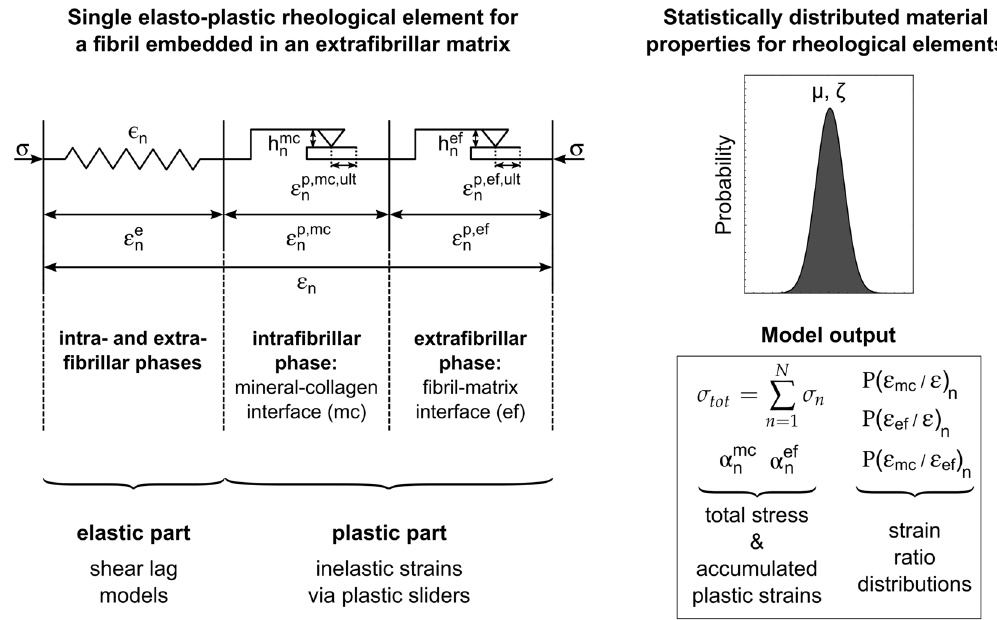
Figure 2. Elasto-plastic rheological model element to incorporate two inelastic strain mechanisms for the mineral-collagen (intrafibrillar) and fibril-matrix (extrafibrillar) interface coupled with a statistical material description. Left, a single rheological model element combines an elastic spring and two plastic sliders for these interfaces, which are set in series, and are loaded under a compressive stress σ . The series arrangement reflects the underlying shear lag and allows different strains in the intra- and extrafibrillar phases. ǫ denotes the apparent fibre Young’s modulus, which is calculated via the shear lag models. Linear hardening is considered via h mc and h ef . The plastic sliders are deactivated when they reach ultimate strain values ε p , mc , ult or ε p , ef , ult , respectively A parallel arrangement represents a fibre (Results section "Statistical material properties" and Fig. 1). Right, the mechanical properties of single elements varied statistically to simulate the effect of micro- and nanoscale heterogeneity (Methods sections “Elasto-plastic constitutive model for a fibril array” and "Model parameters" including Table 2). The model outputs the total stress as the sum of the partial stresses (Supplementary Sect. S1), accumulated plastic strains in the intra- and extrafibrillar phases, and strain ratio distributions between the apparent fibre and its constitutive